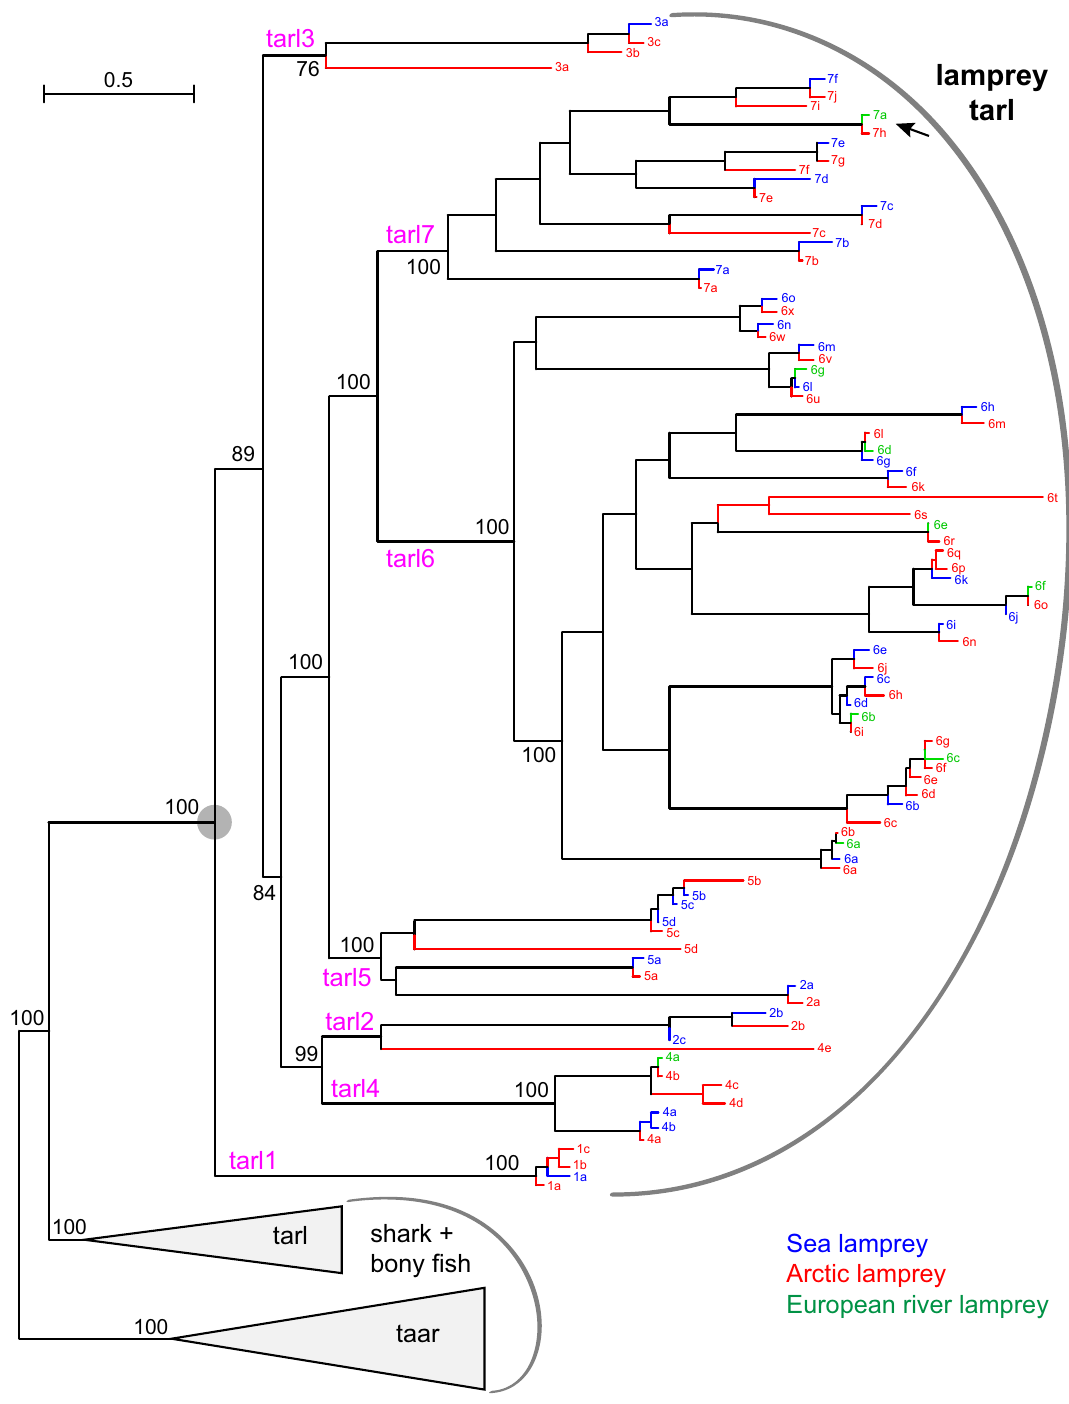
Figure 5. Phylogenetic tree of lamprey taar -like genes. Phylogenetic tree of taar and taar -like genes, with all nodes collapsed (grey triangles) except lamprey taar -like genes (ancestral node denoted by grey circle). Gene set and tree construction are same as in Fig. 1. European river lamprey, Lampetra fluviatalis ; Arctic lamprey, Lethenteron camtschaticum ; Sea lamprey, Petromyzon marinus . Genes are indicated by colour code for the species as shown and the unique part of the gene name, e.g. 1a (red) denotes tarl1a of the arctic lamprey. Magenta, predicted ancestral genes. Note close arctic lamprey orthologs for all tarl genes from European river and sea lamprey. Black arrow, European river lamprey tarl7a , whose expression is shown in Fig. 4. Numbers indicate % branch support for basal nodes (cutoff 80%). Scale bar, number of amino acid substitutions per